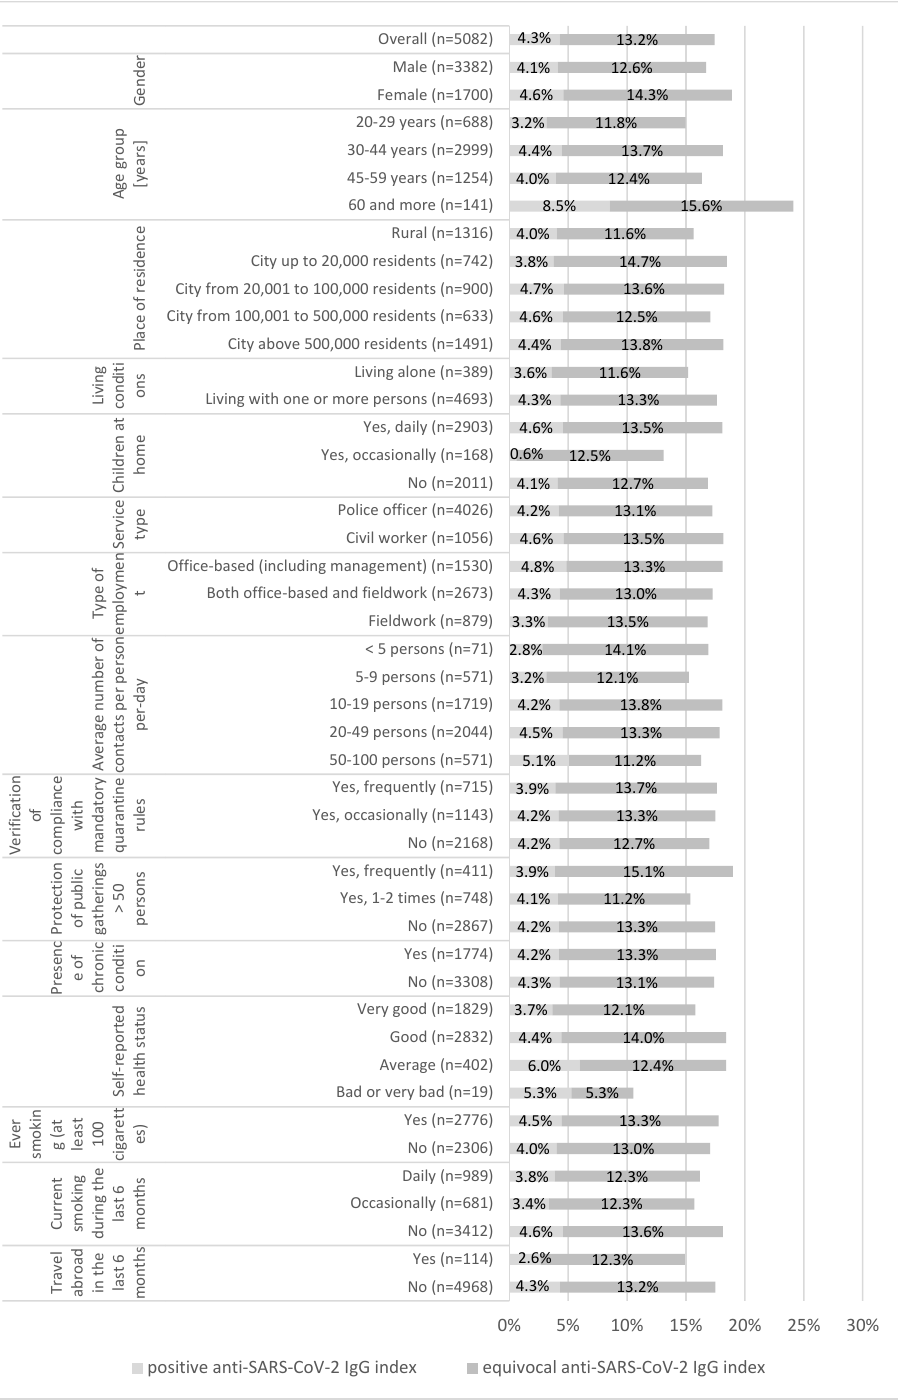
Figure 2. The prevalence of positive and equivocal anti-SARS-CoV-2 IgG index among 5082 police employees from Mazowieckie Province, Poland, presented by the personal and occupational characteristics.